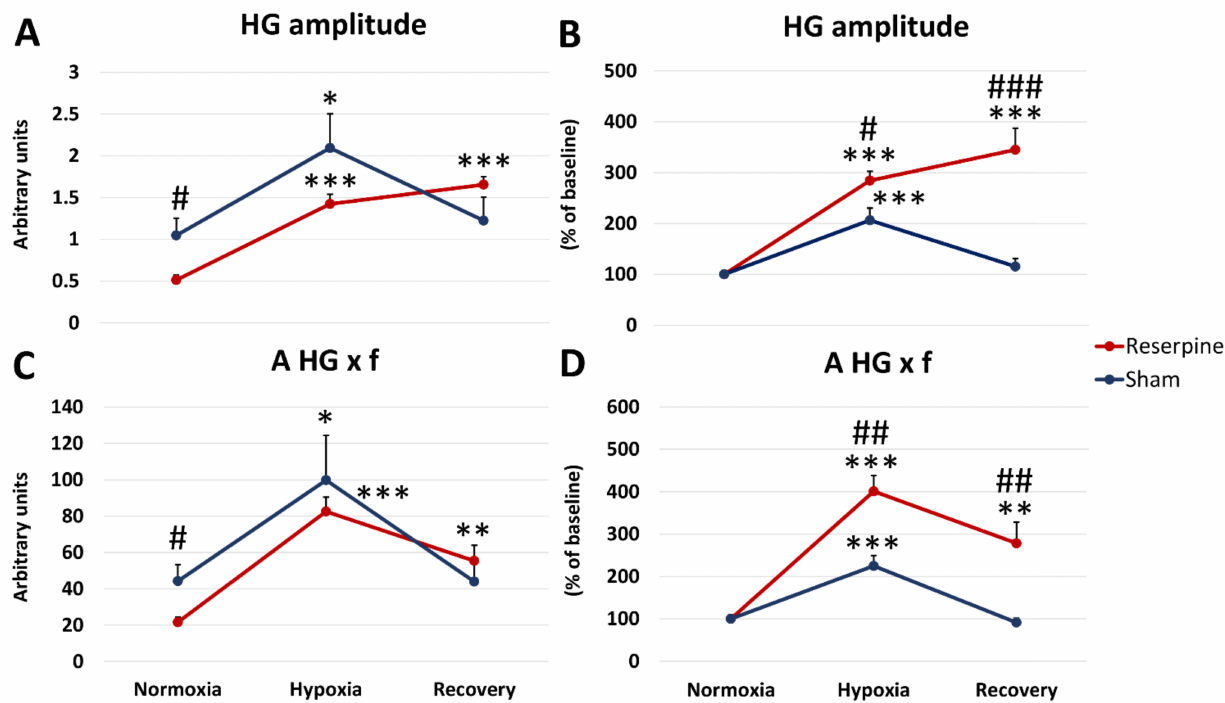
Figure 2. The average amplitude ( A , B ) and minute activity (A × f) of the hypoglossal nerve (HG) ( C , D ) during normoxia, hypoxic ventilatory response, and recovery in animals subjected to a vehicle (sham) or reserpine injection. Results are expressed as absolute values ( A , C ) and a percentage of the baseline nerve activity (expressed as 100%) ( B , D ) before hypoxia. All values are means ± SEM. *# P < 0.05, **## P < 0.01, ***### P < 0.001,*—statistical significance in comparison to normoxic value, #—statistical significance between corresponding values in reserpine and sham groups ( n = 7–9 per